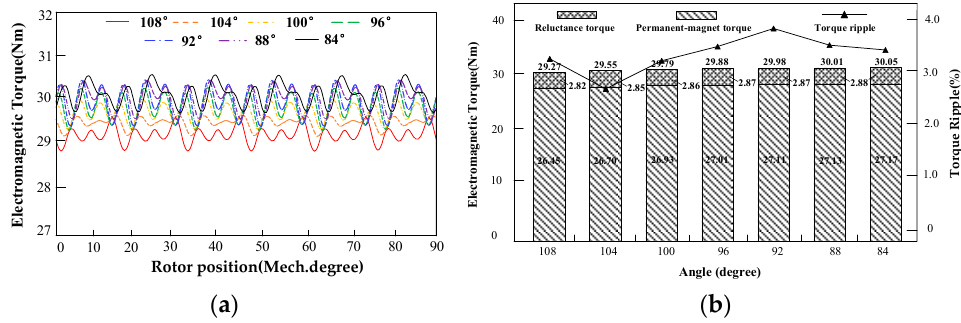
Figure 14. ( a ) Electromagnetic torque with different angle between the V-type permanent magnets; ( b ) The average value of electromagnetic torque and torque ripple with different angle between the V-type permanent magnets.